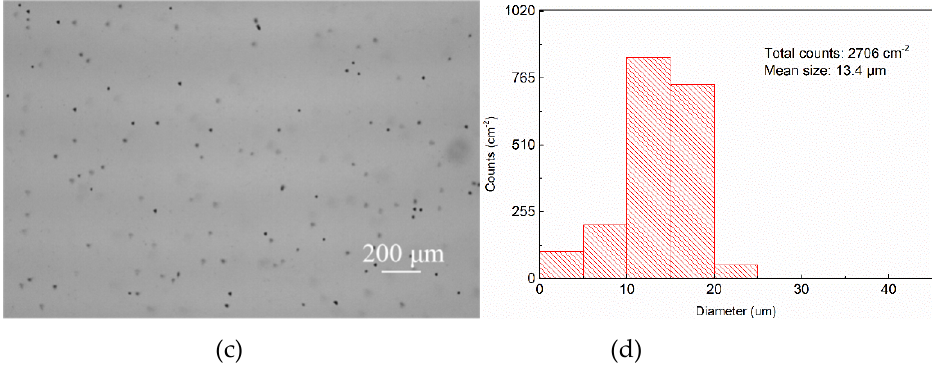
Figure 5. ( a ) and ( c ) IRTM images of Te inclusions in CZT4 and CZT3, respectively; ( b ) and ( d ) statistical data showing inclusion numbers and diameters in CZT4 and CZT3, respectively.